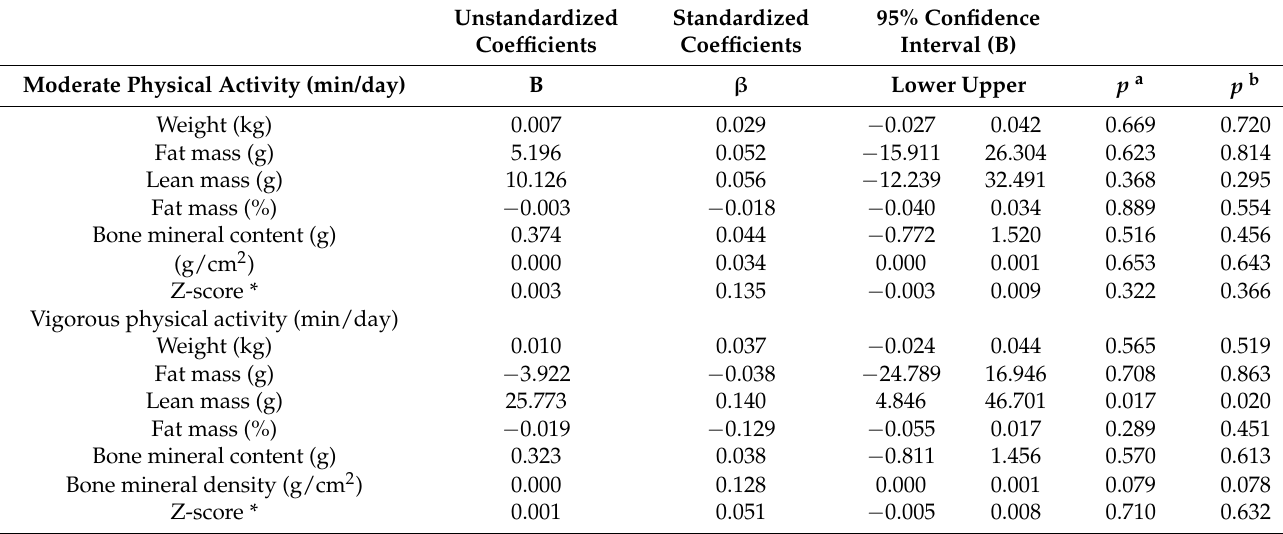
Table 3. Linear regression assessing the association between moderate and vigorous physical levels and body composition in children with celiac disease ( n =